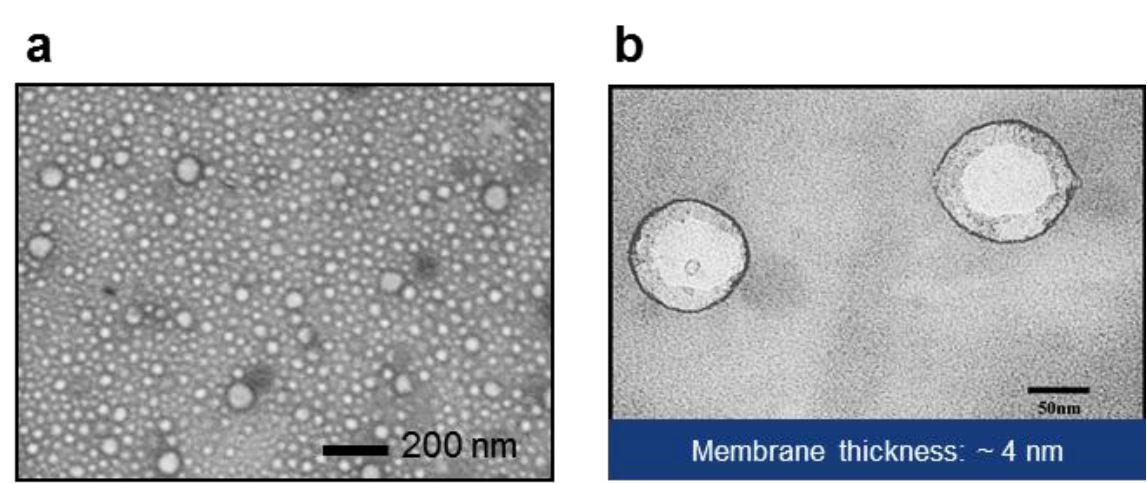
Figure 3. ( a ) Low- and ( b ) high-magnification TEM images of polymersomes (PEOX-PDMS-PEOX), with wall thickness of about 4 nm. Image in ( b ) adapted with permission from [43] (Copyright 2007